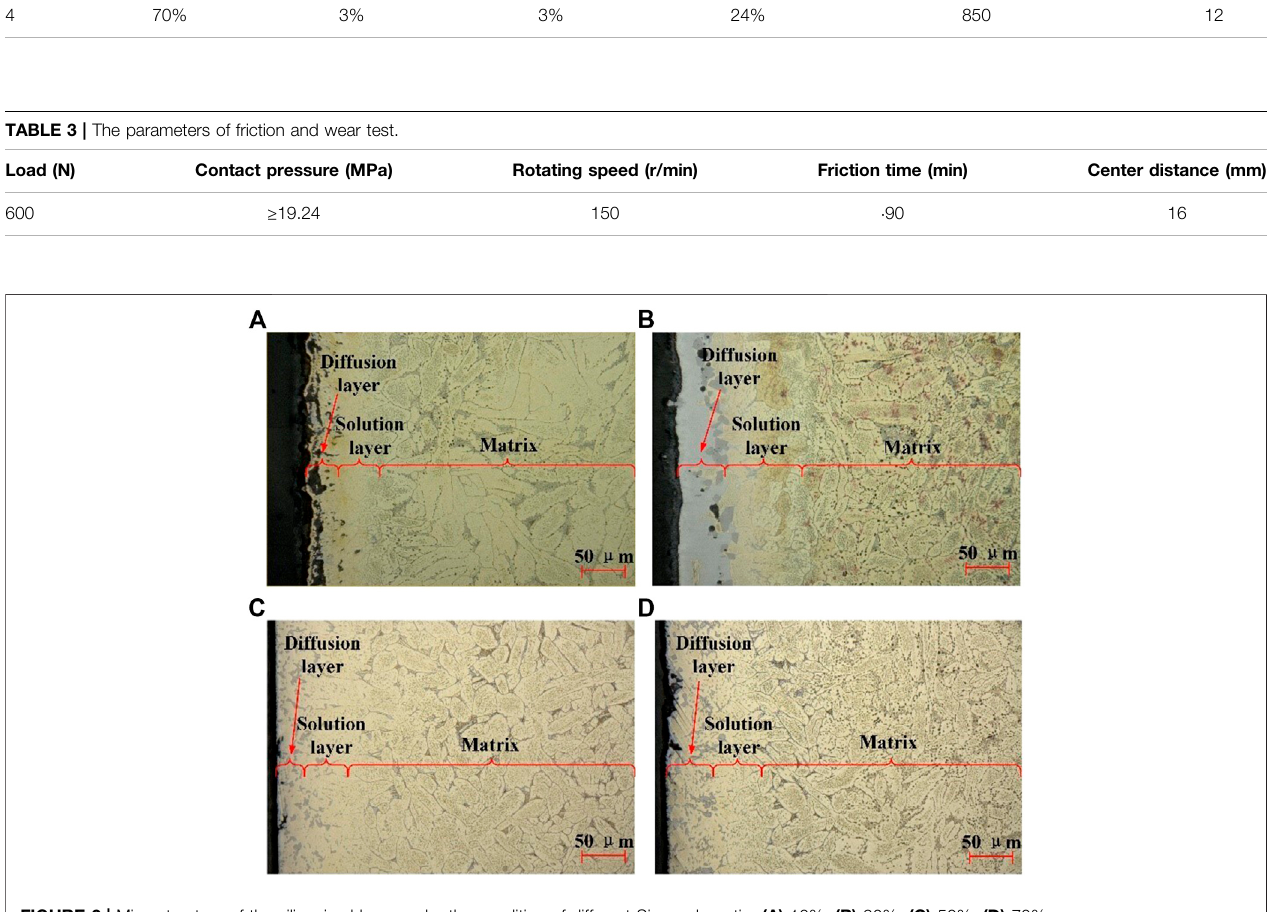
Frontiers in Materials |